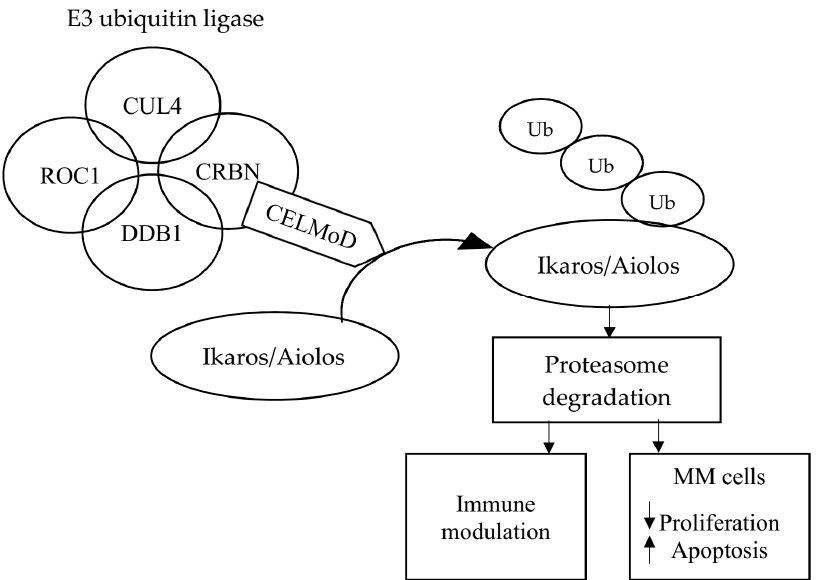
Figure 3. Molecular mechanism of action of cereblon E3 ligase modulators in multiple myeloma.